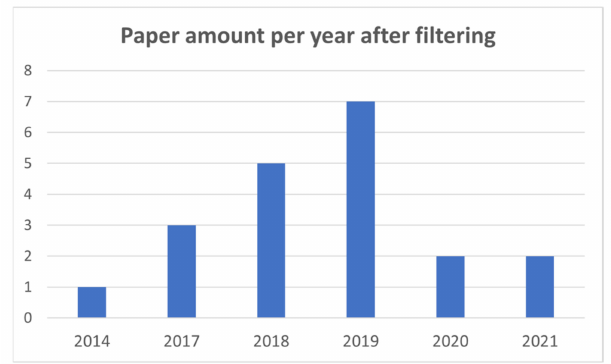
Figure 2. Paper amount per year after the application of the filtering process.